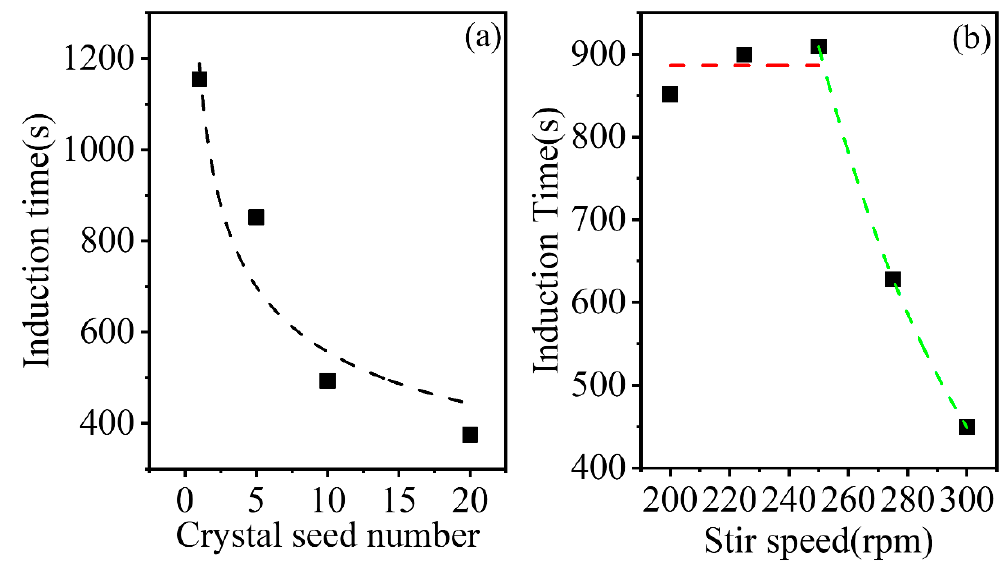
Figure 7. Induction time of experiments with different seed numbers ( a ) and stirrer speeds ( b ).